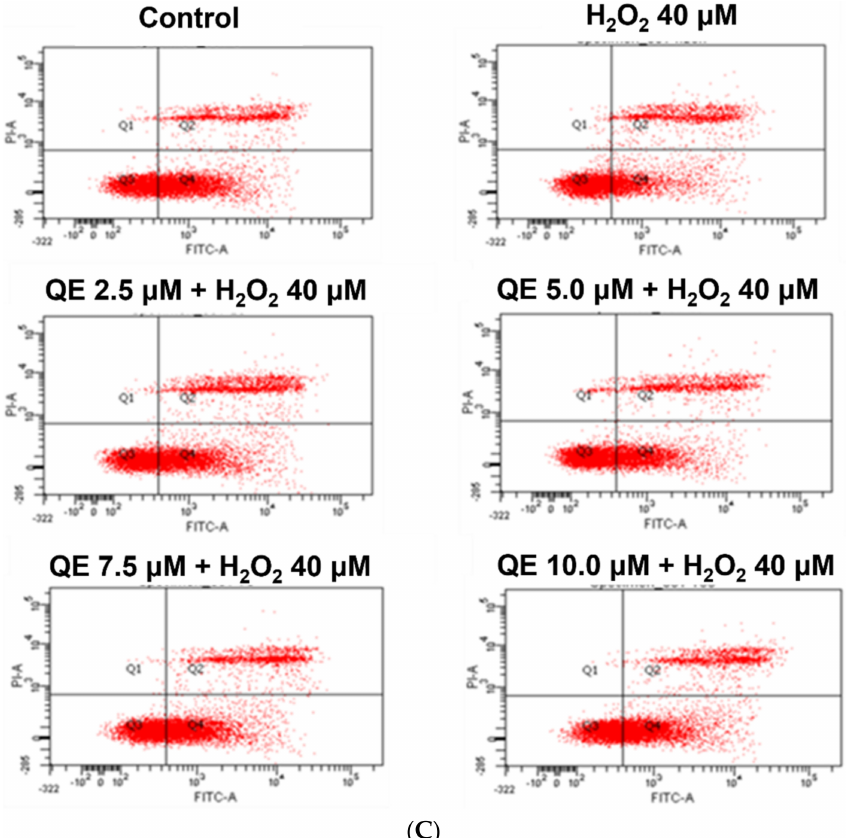
Figure 6. Effects of quercetin on H 2 O 2 -induced changes in cell apoptosis. ( A ) Western blot analysis of active-caspase 3 expression in SH-SY5Y cells. ( B ) Percentages of apoptotic cells in each group quantified from ( C ). ( C ) Representative profiles of cell apoptosis detected by flow cytometry with Annexin V/propidium iodide double-staining. The cells were cultured with 0.0, 2.5, 5.0, 7.5 and 10.0 µ M of quercetin for 24 h and then treated with 40 µ M of H 2 O 2 for 24 h. Data were presented as mean ± SD. # Data are analyzed using an independent t -test and are significantly different from the control group. Bars of 0, 2.5, 5.0, 7.5, and 10.0 µ M quercetin with different letters